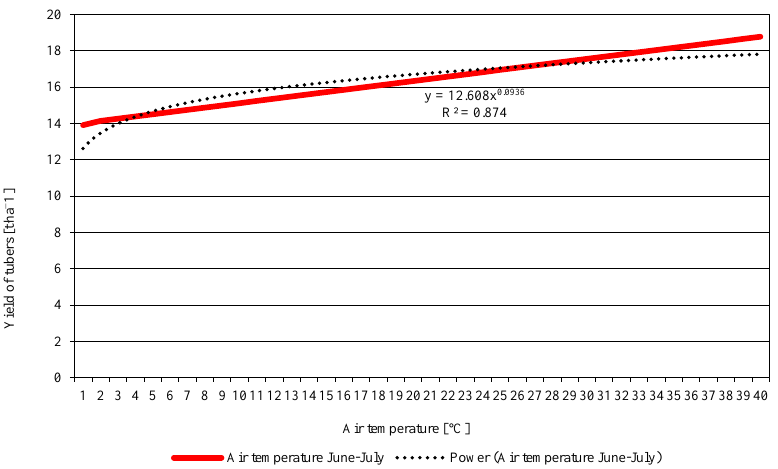
yields. This fact is confirmed by the coefficient of determination (R 2 = 87.4%).